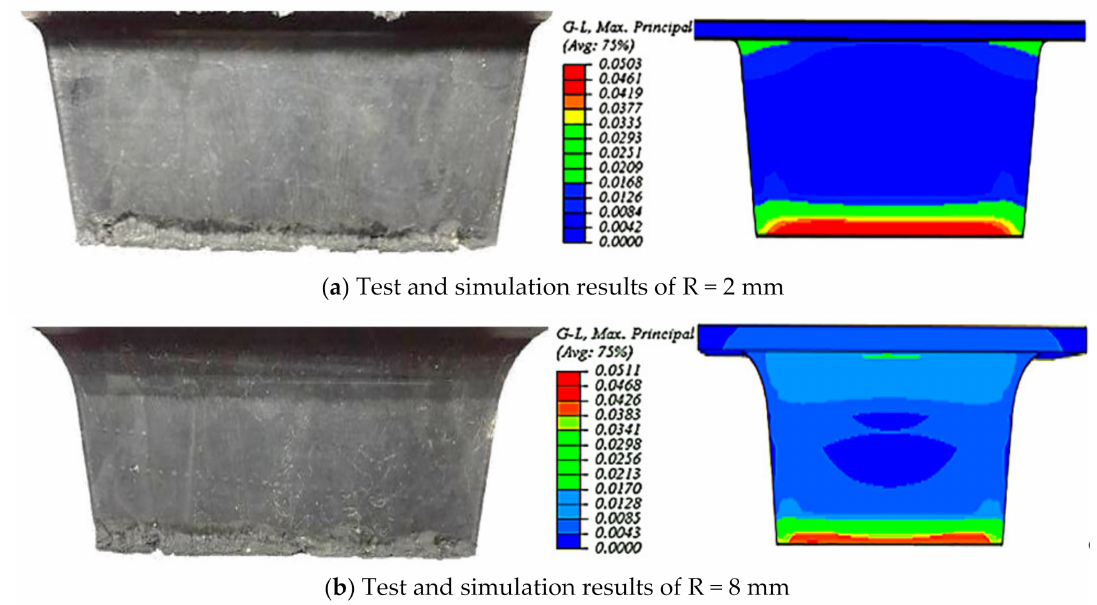
Figure 11. Comparison of the test and simulation results of the slide